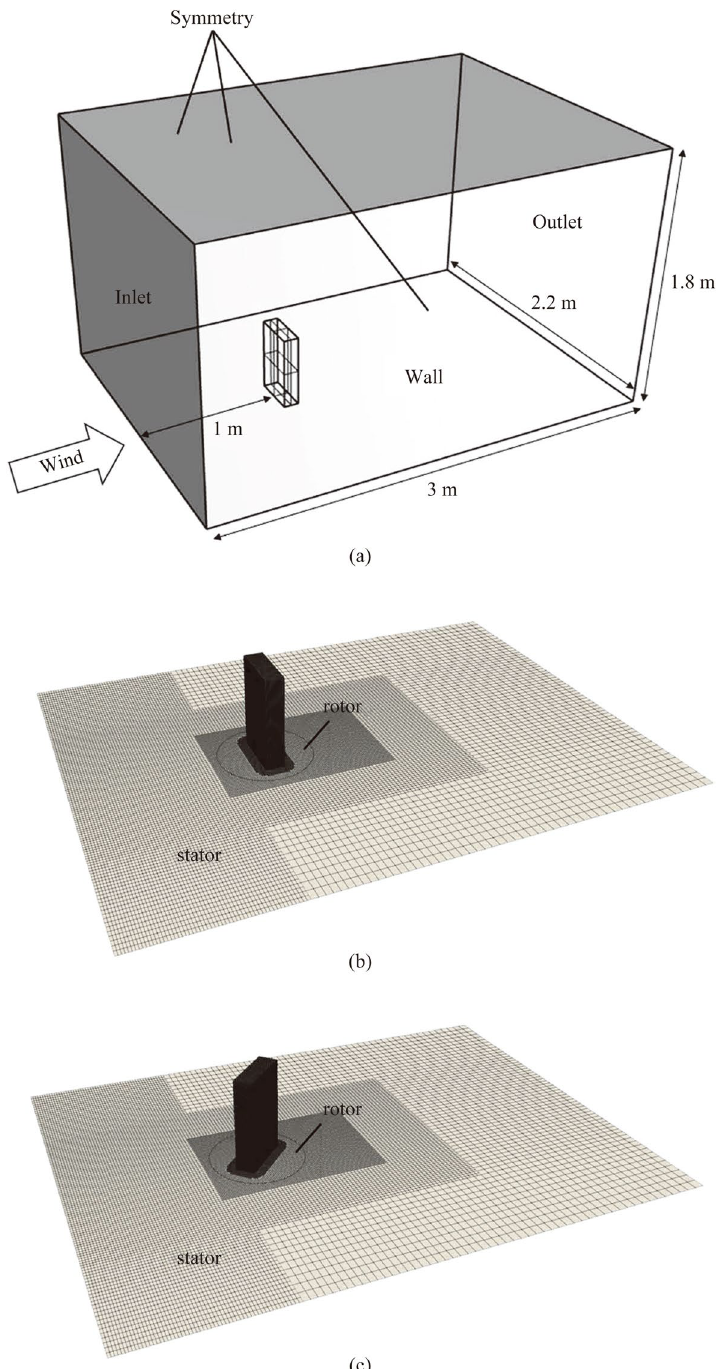
Fig. 2 The computational domain with boundary conditions ( a ) and the overviews of the mesh distribution: 0 ◦ ( b ) and 45 ◦ ( c